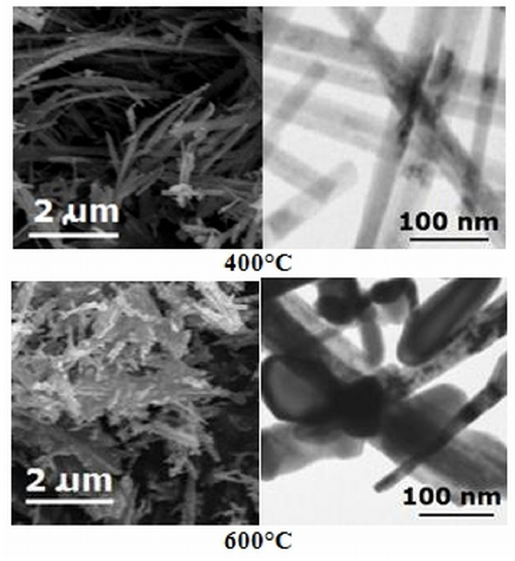
nanowires calcined at 400 2